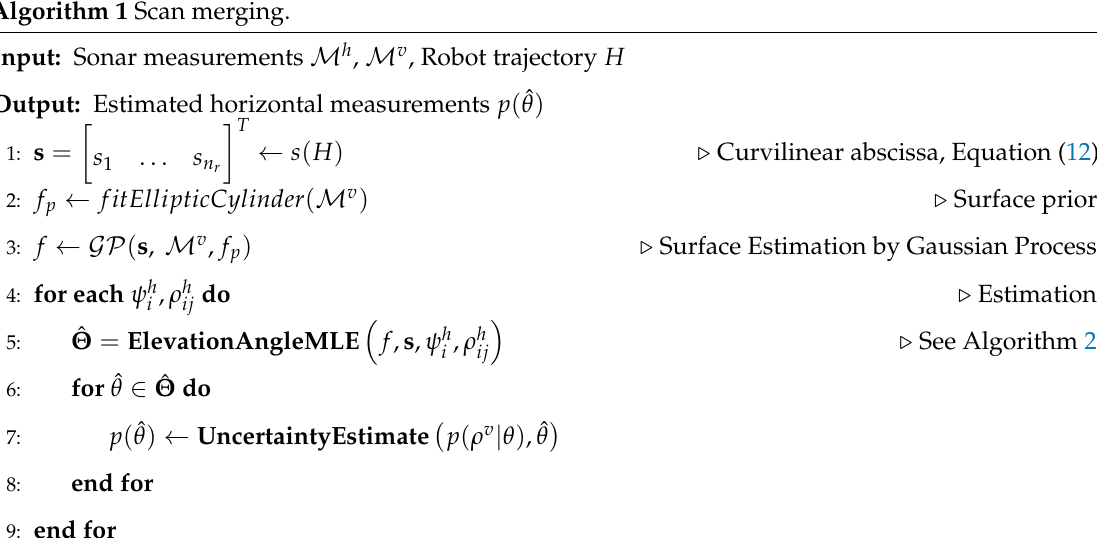
Figure 9. Thresholds σ l , σ m and σ T relative to ¯ θ with b = 0.61 radians (35 deg). Algorithm 1 Scan